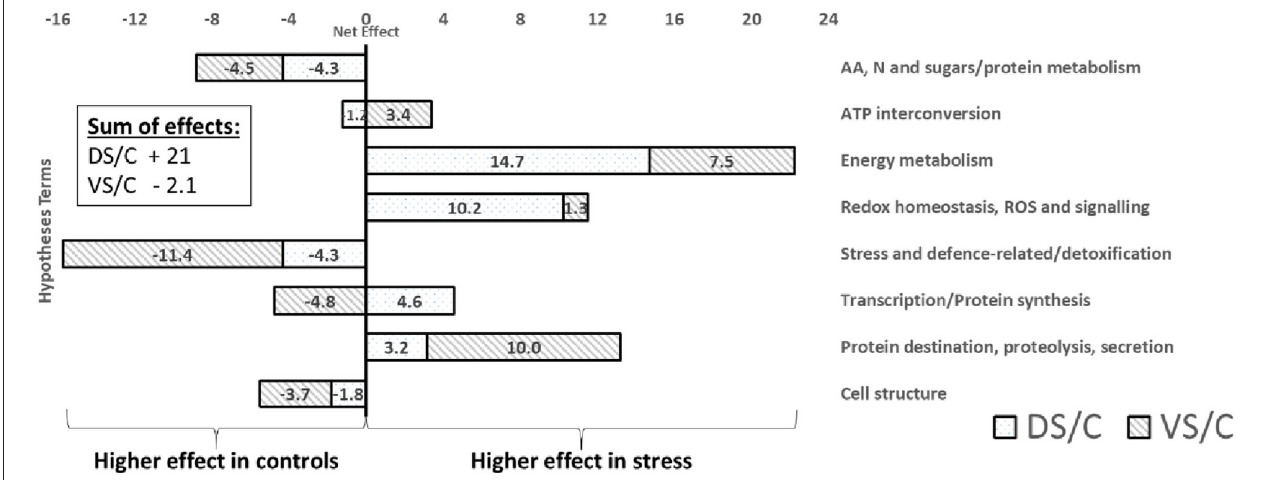
FIGURE 6 | GOModeler output. The GOModeler-based graphical summary of proteome net effects for each of eight chosen hypotheses terms (right side), showing net effects on treated protein accumulation (protein abundance change). The net effect is a product of quantitative value (logarithm of protein abundance expressed as stress density/control density) with qualitative value ( + 1, 0, or − 1; assessed by GOModeler according to GO annotation of each protein). In the corner, the sum of all net effects for individual combinations is calculated. A positive value (right side of the graph) means higher protein net effect in treated plants; negative values mean higher net effect importance in